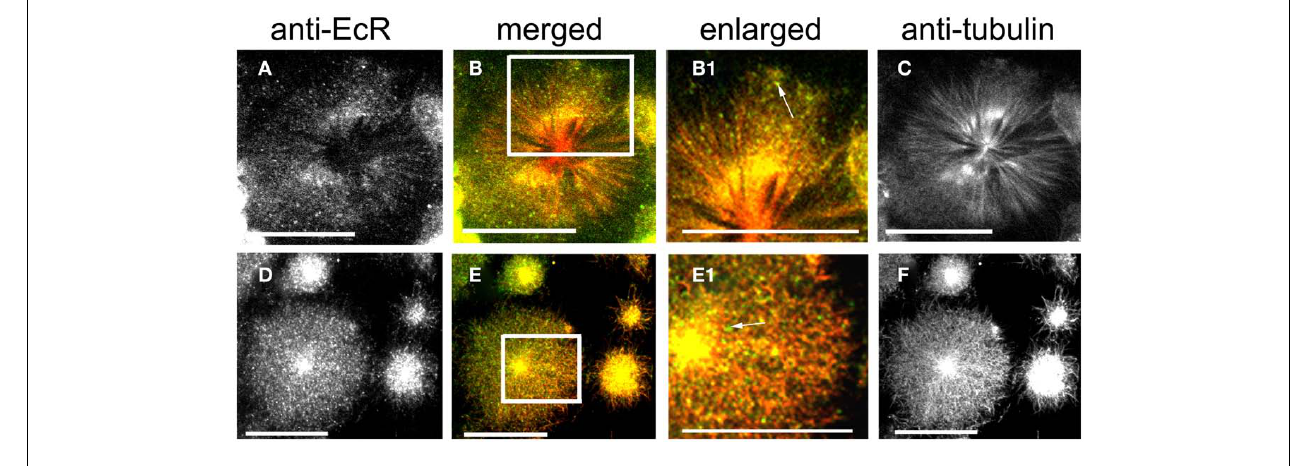
arrangement of MTs from a well defined centrosome. Areas enclosed in the white lined boxes in (B,E) are shown in the enlarged column as (B1,E1) respectively. Note the co-localization of EcR fluorescence with MTs (yellow specks) in (B1,E1) . Some EcR fluorescence does not associate with MTs [green specks, arrows in (B1,E1) ]. Scale bars = 10 μ m.